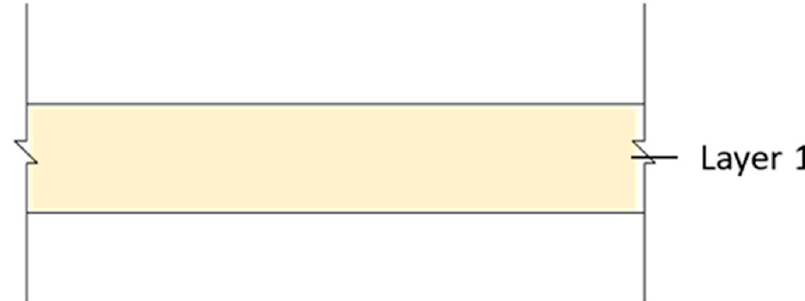
Figure 1. The diagram of the single wall (A1).